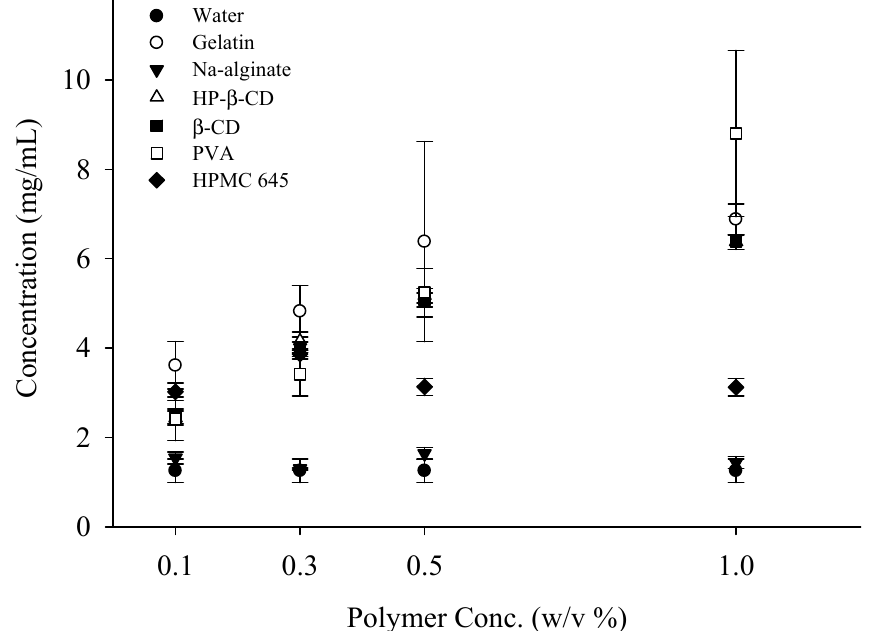
Figure 1. Effect of polymer concentration (0.1, 0.3, 0.5, and 1%) on the solubility of RXB. Each value shows the mean ± standard deviation (S.D.) ( n = 3).